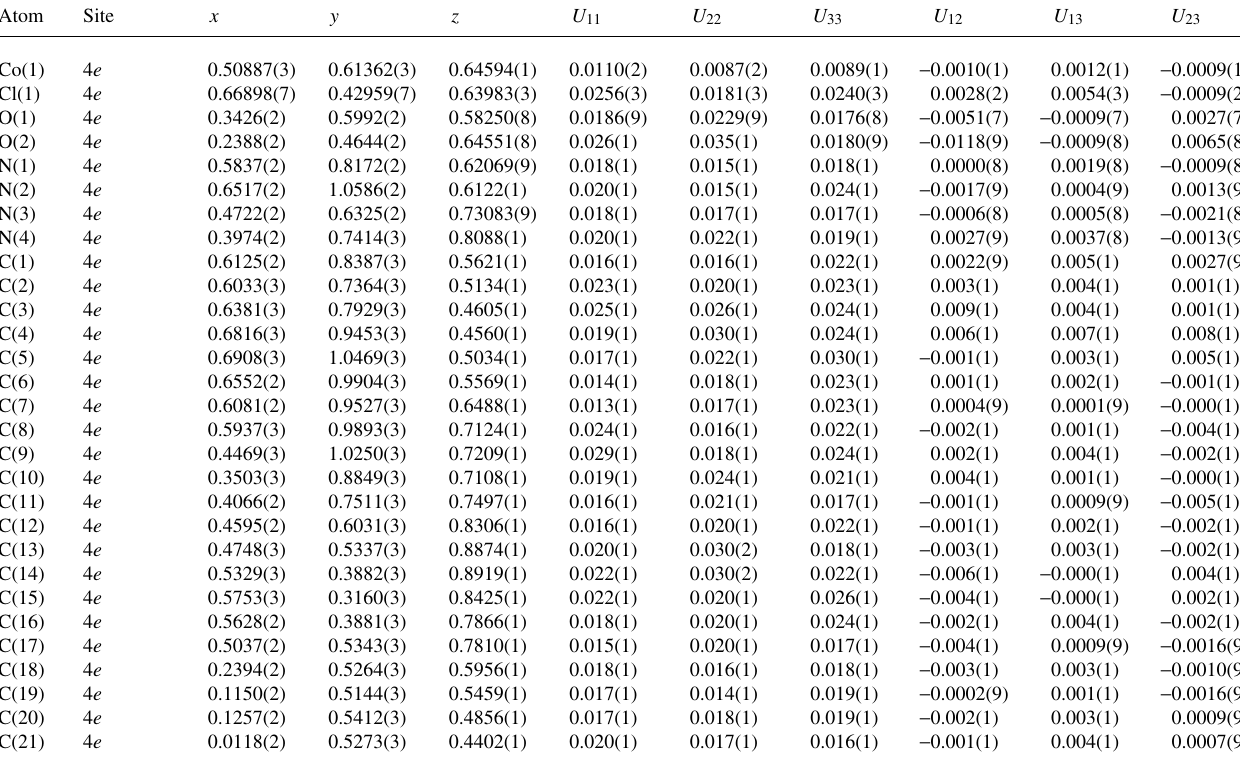
Table 3. Atomic coordinates and displacement parameters (in Å 2 )